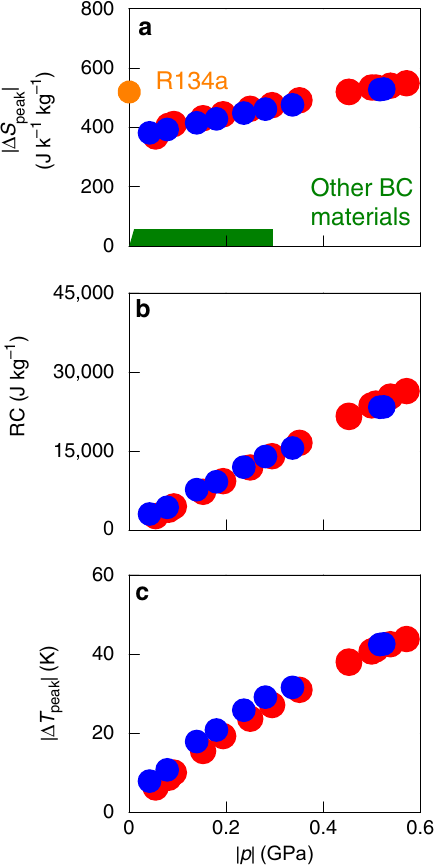
Fig. 4 Barocaloric performance near room temperature. a For NPG, we show the peak isothermal entropy change | Δ S peak | for pressure changes of magnitude | p |, on applying pressure (blue symbols) and removing pressure (red symbols). For comparison, the green envelope represents state-of-the- art barocaloric materials (Table 1) that operate near room temperature, and the orange symbol represents the standard commercial fl uid refrigerant 18 R134a for which operating pressures are ~0.001 GPa. For NPG alone, we show the variation with | p | of b refrigerant capacity RC = | Δ S peak | × [FWHM of Δ S ( T )] and c peak values of the adiabatic temperature change | Δ T peak |, on applying pressure (blue symbols) and removing pressure (red